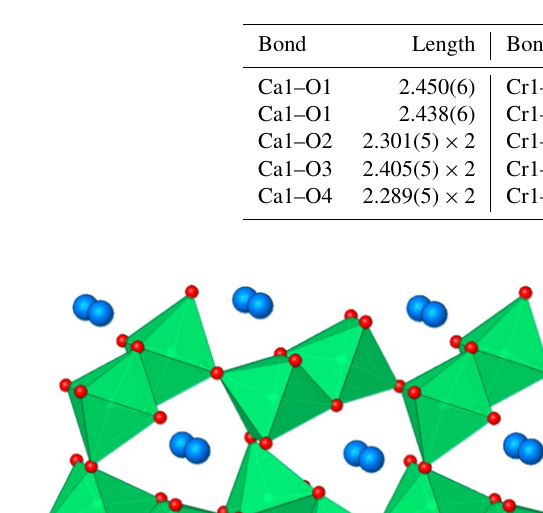
Table 6. Selected bond lengths (Å) for ellinaite (Hatrurim Basin).